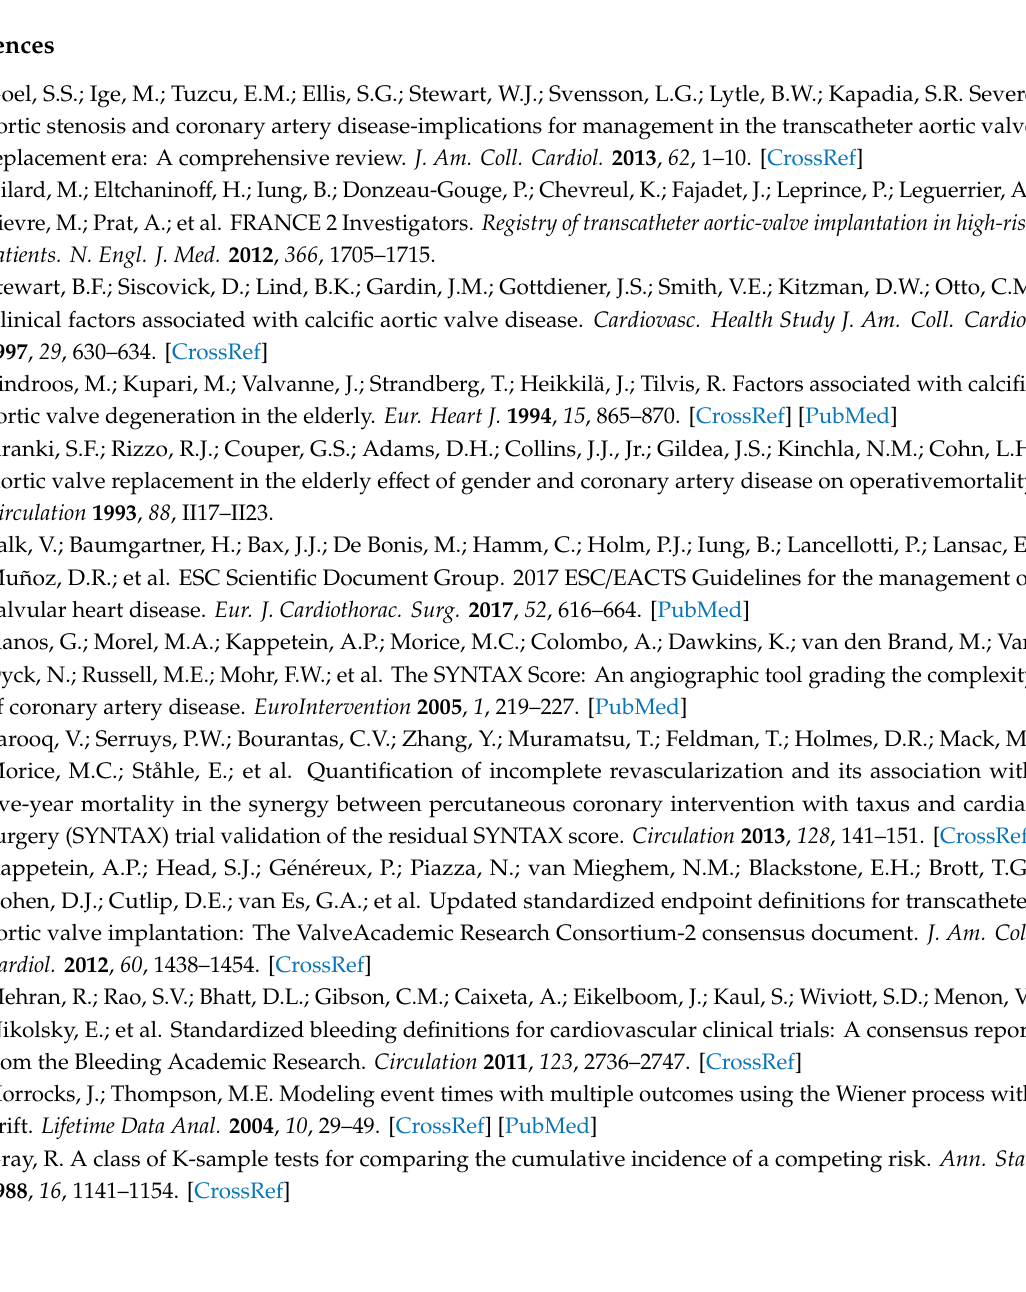
Figure S2B: Kaplan–Meier analyses for myocardial infarction-free survival probability, according to SRI cut o ff value of 80, Figure S3A: Cumulative incidence analysis for Major / life threatening bleeding events-free survival probability according to bSS cut o ff value of 22; Figure S3B: Cumulative incidence analysis for Major / life threatening bleeding events-free survival probability according to SRI cut o ff value of 80; Table S1: Baseline characteristic according to baseline SYNTAX score (bSS), Table S2: Multivariate analysis of association between bSS with baseline characteristics and late major / life-threatening bleeding (MLBCs)